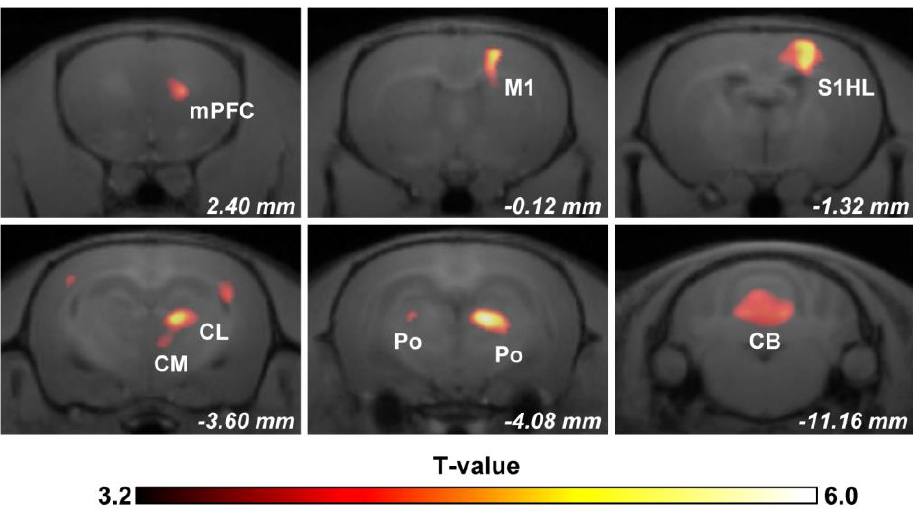
Figure 3. Regions of the brain activated in response to mechanical allodynia superimposed upon MRI coronal images. The images were obtained via a voxel-based statistical comparison between the FDG uptake of the SNL ( n = 10) and sham-operated rats ( n = 12). The T-value of 3.2 used as the threshold in the figure corresponds to the p < 0.002 (uncorrected) threshold. The right side of the images corresponds to the right hemisphere. The numbers in white indicate the anterior-posterior level of the coronal slices according to the rat brain atlas (Paxinos and Watson). Abbreviations: mPFC, medial prefrontal cortex; M1, primary motor cortex; S1HL, primary somatosensory cortex, hindlimb region; CL, centrolateral thalamic nucleus; CM, central medial thalamic nucleus; Po, posterior thalamic nuclei; CB,